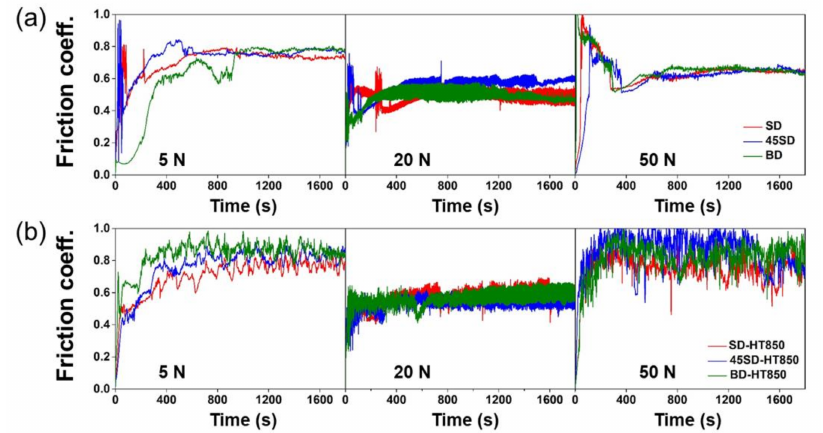
Figure 8. Evaluation of COF with time during wear tests against AISI 52100 bearing steel ball of samples in ( a ) as-built and ( b ) HT850 heat